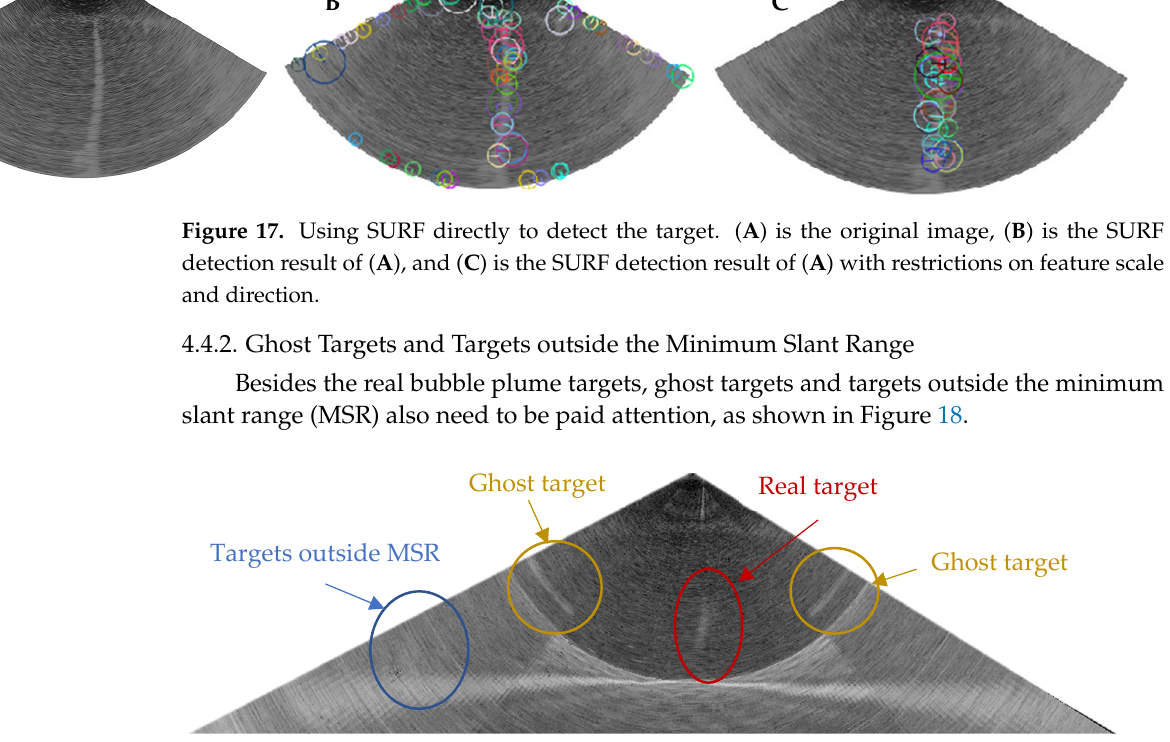
Figure 17. Using SURF directly to detect the target. ( A ) is the original image, ( B ) is the SURF detec- tion result of ( A ), and ( C ) is the SURF detection result of ( A ) with restrictions on feature scale and direction.